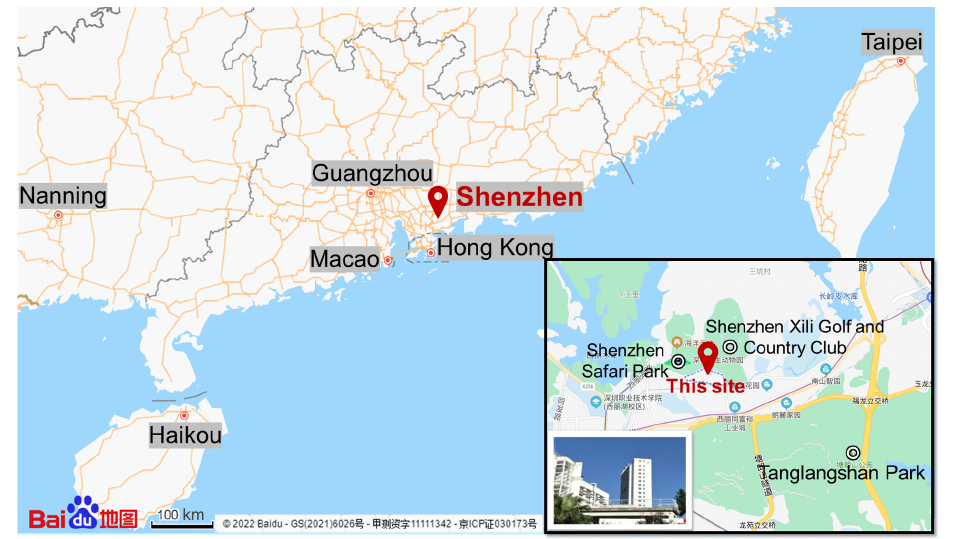
Figure 1. Geographical location and surrounding environmental conditions of the measurement site in the STORM campaign (the maps are from https://map.baidu.com, last access: 22 August